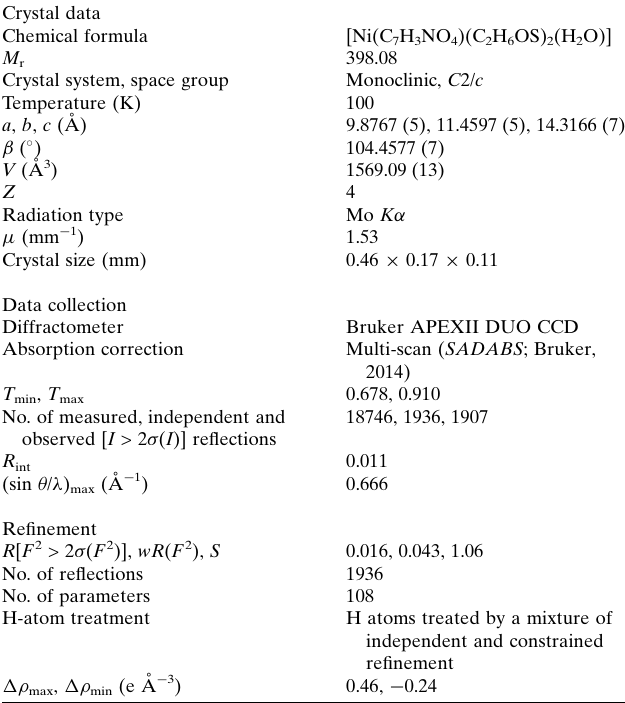
Table 2 Experimental details. Crystal data Chemical